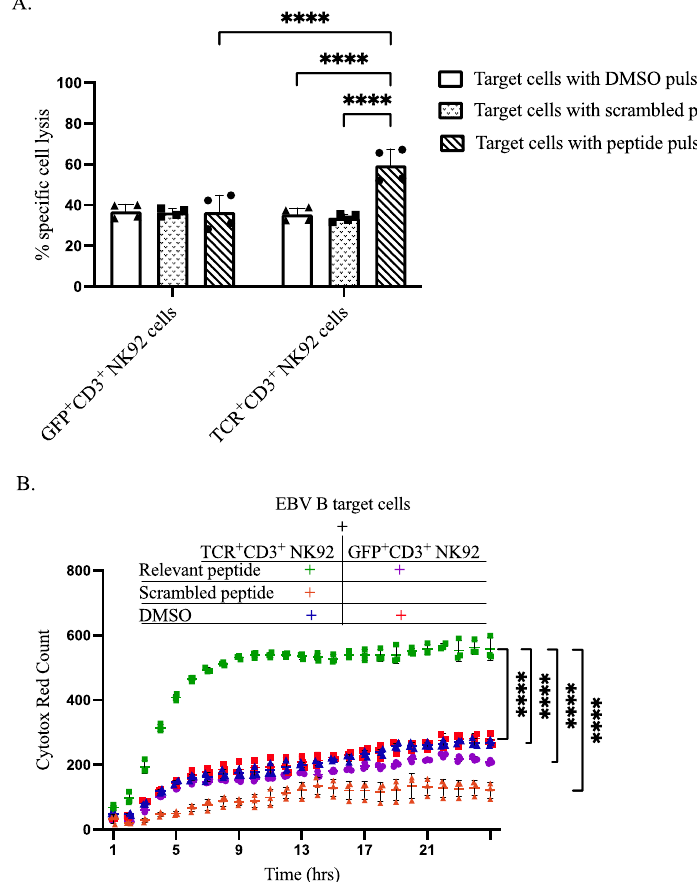
Figure 5. Cytotoxicity of sorted genetically modified NK92 cells upon co-cultured with target cells. ( A ) Flow cytometry-based In Vitro killing assay. Target cells were pulsed by incubation with DMSO, relevant peptide, or scrambled peptide for 2 h. Then genetically modified NK92 cells (GFP + CD3 + or TCR + CD3 + NK92 cells) were labeled with CTV and co-cultured with pulsed target cells at a ratio of 1:3 for 2 h. After incubation, whole-cell populations were harvested and stained for flow cytometry determinations. Flow cytometry data were analyzed by FlowJo, dead cells were gated from CTV negative cells. The **** indicates a statistically significant p < 0.0001. ( B ) In vitro cytotoxic live cell imagining activity of sorted genetically modified NK92 cells. To assess the cytotoxic activity of generated GFP + CD3 + and TCR + CD3 + NK92 cells by IncuCyte S3 live-cell analysis system, labeled NK92 cells were co-cultured with target cells at an E:T ratio of 1:1 without having peptide throughout the assay. The magnification power was the same for all images. Data analysis was performed from real live-cell images, and cytotox red counts as dead target cell markers were extracted per time. Normal death baseline was subtracted from each separately. Each dot represents the mean of triplicate data (each datum derived from four images). The **** indicates a statistically significant p <